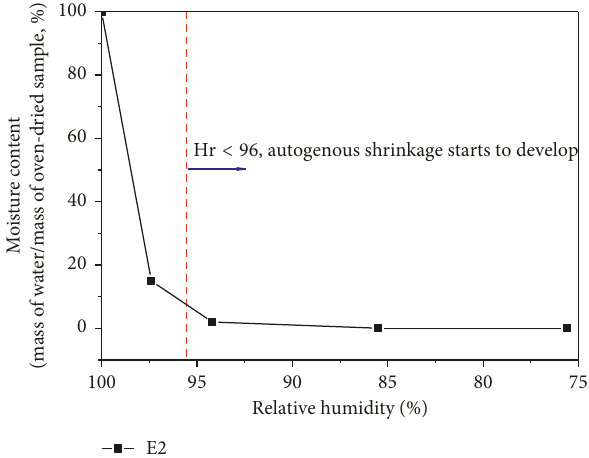
Figure 5: Water desorption properties of saturated perforated